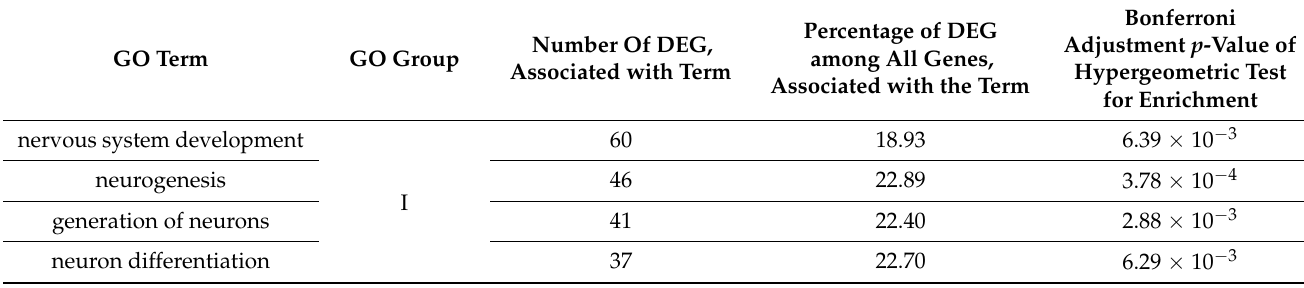
Table 3. Significantly enriched GO BP terms for DEG